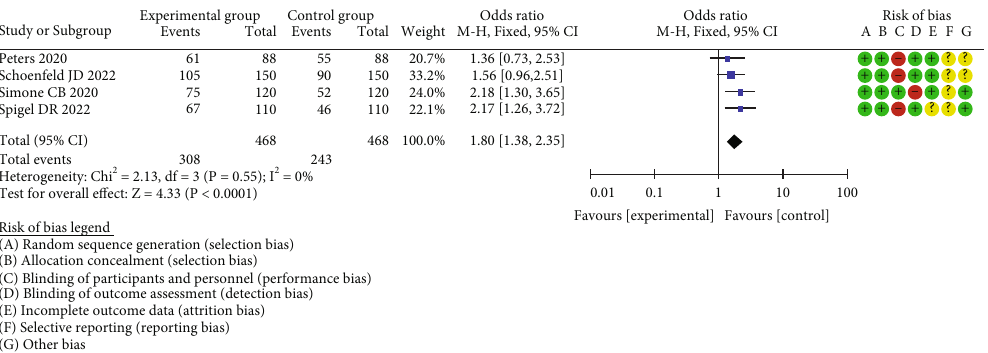
Risk of bias legend (A) Random sequence generation (selection bias) (B) Allocation concealment (selection bias) (C) Blinding of participants and personnel (performance (D) Blinding of outcome assessment (detection bias) (E) Incomplete outcome data (attrition bias) (F) Selective reporting (reporting bias) (G) Other bias Figure 4: Meta-analysis of the e ff ect of adoptive immunotherapy on overall survival between two